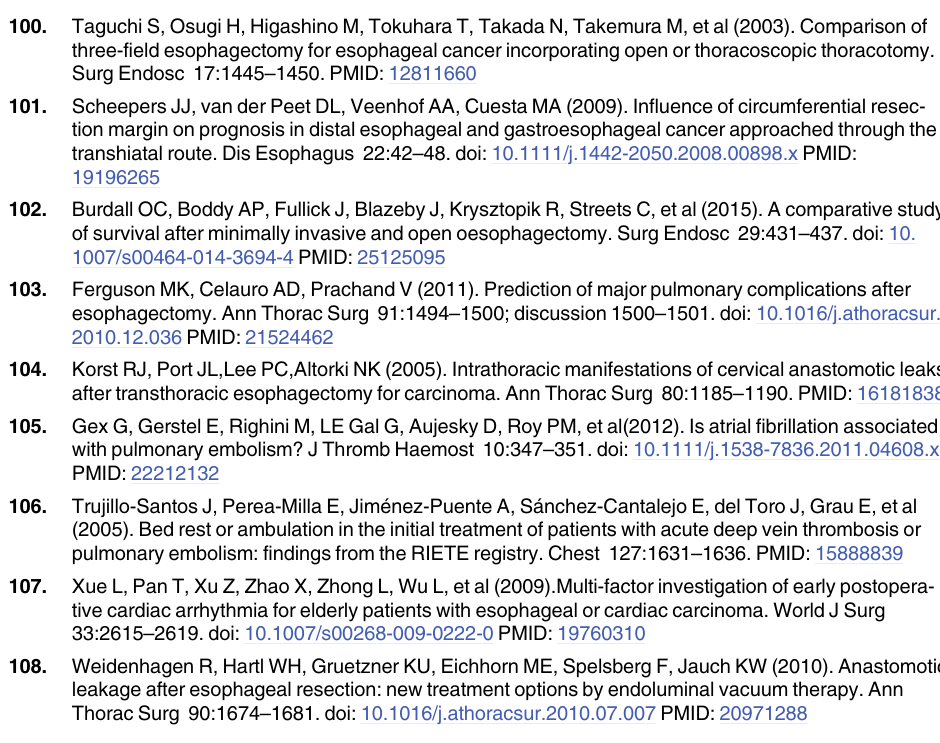
PLOS ONE | DOI:10.1371/journal.pone.0132889 July 21,